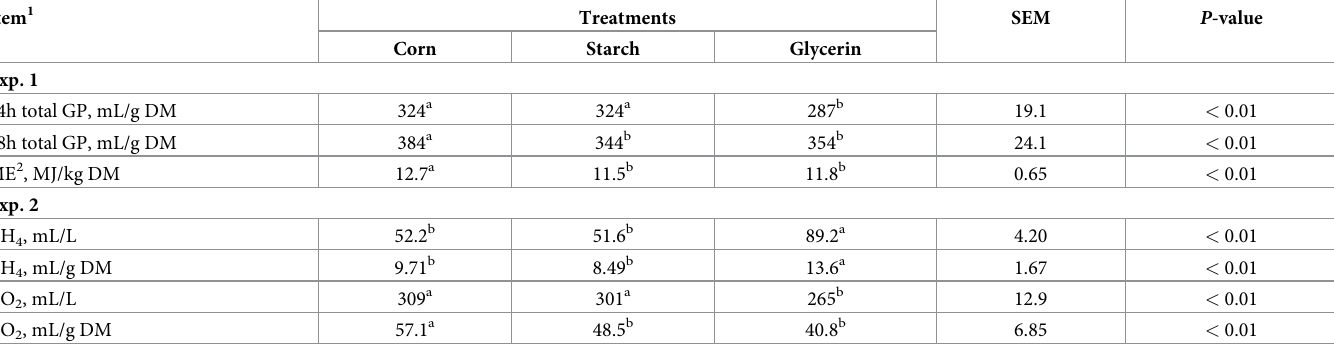
Table 2. Effects of different ingredients on total gas production (GP), metabolizable energy (ME), and enteric methane (CH 4 ) and carbon dioxide (CO 2 ) production in GP systems. Item